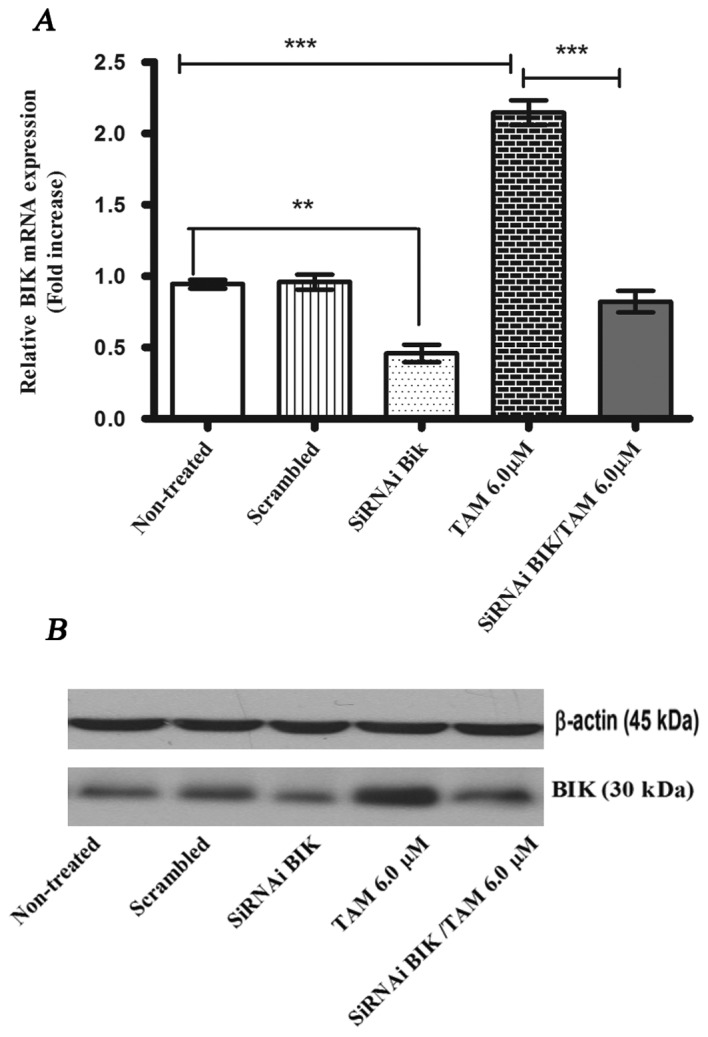
Transfection and silencing of Bik in the human breast cancer line MCF-7. (A and B) Cells were transiently transfected with Bik-specific (BIK) or sequence-scrambled control and them cultured in the presence or absence of 6.0 μM of tamoxifen (TAM) for 24 h, followed by evaluation of expression of Bik and β-actin (as control) by real-time RT-PCR and western blot analysis. The groups were analyzed by one-way ANOVA with the Tukey’s test. *p<0.05; **p<0.01; ***p<0.001 vs. non-treated. Representative figures of three independent experiments carried out in triplicate are shown.